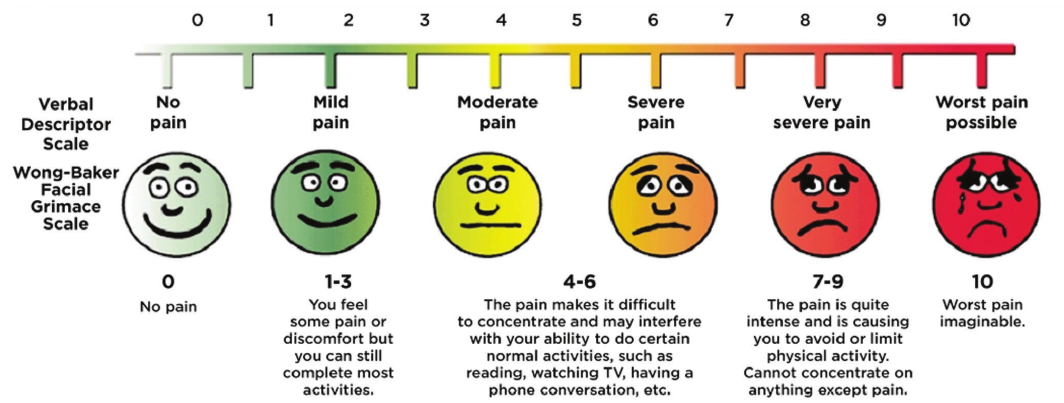
Figure 1. Universal pain assessment